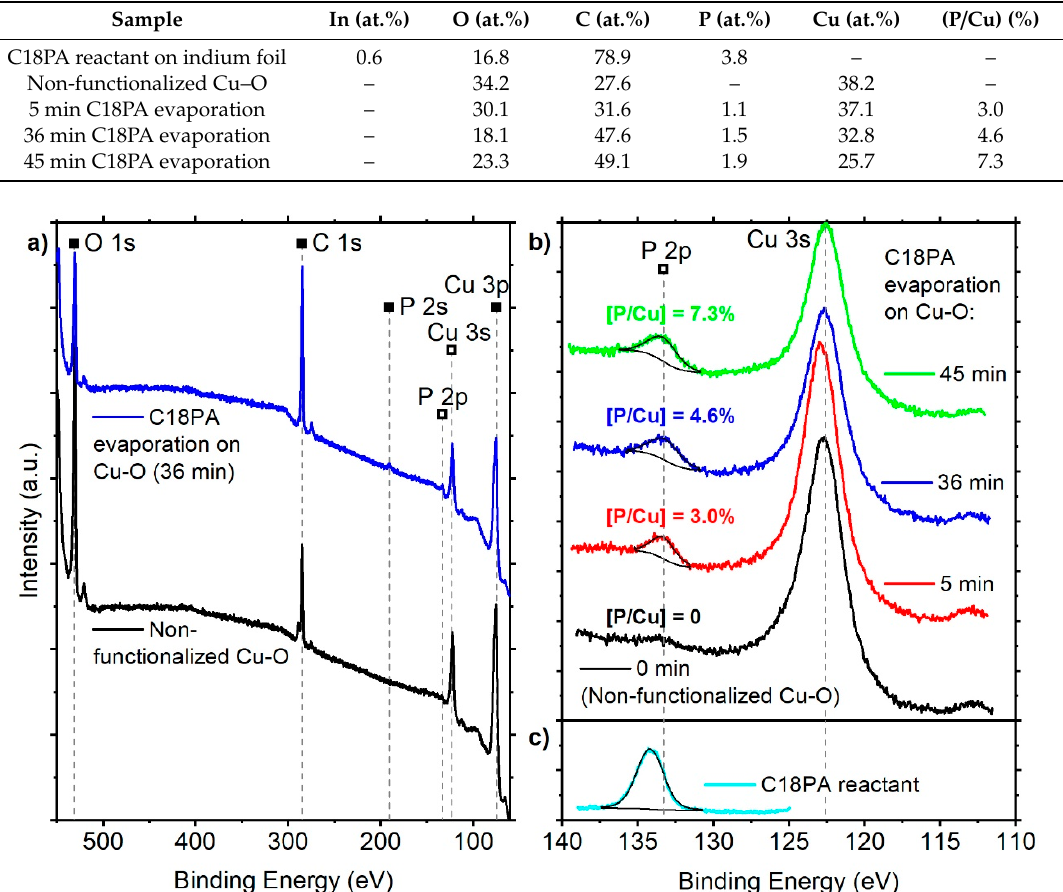
Table 1. Chemical composition of C18PA reactant as well as of functionalized and non-functionalized surfaces obtained by photoelectron signals of elements labeled with filled symbols in Figure 2a.